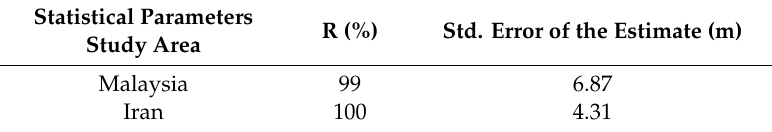
Figure 5. The location of the systematic points. Table 2. The values of linear regression and standard errors of the estimate.